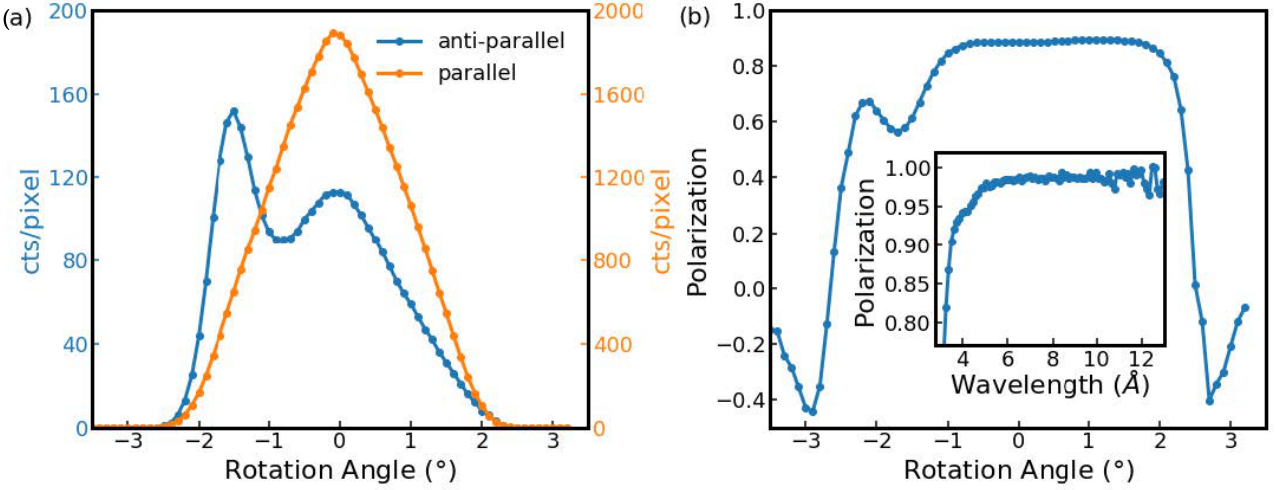
Figure 4. Rocking scans of the transmission bender–collimator combination measured at λ =6Å in MIEZE configuration at RESEDA. ( a ) Polarization of the incident neutrons parallel (orange) and antiparallel (blue) to the analyzing direction. ( b ) Polarization calculated from the data shown in panel ( a ). The inset of ( b ) shows the fully corrected (Fredrikze method [19]) polarization of the bender as a function of the wavelength as measured at OFFSPEC.